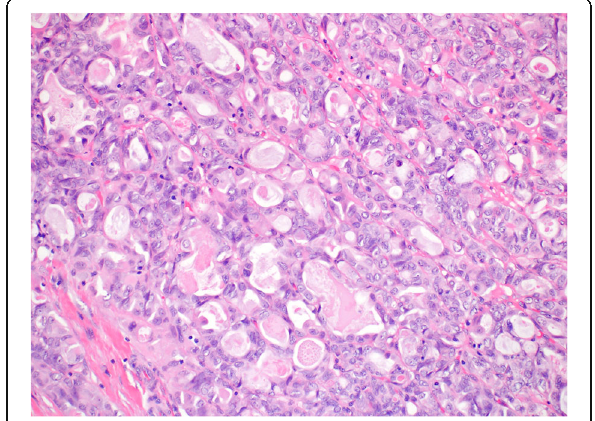
Fig. 3 Higher magnification of mesonephric-like adenocarcinoma, showing tumor cells with vesicular nuclei and small nucleoli. Note the few cells with hobnail nuclei (HE, 200x)